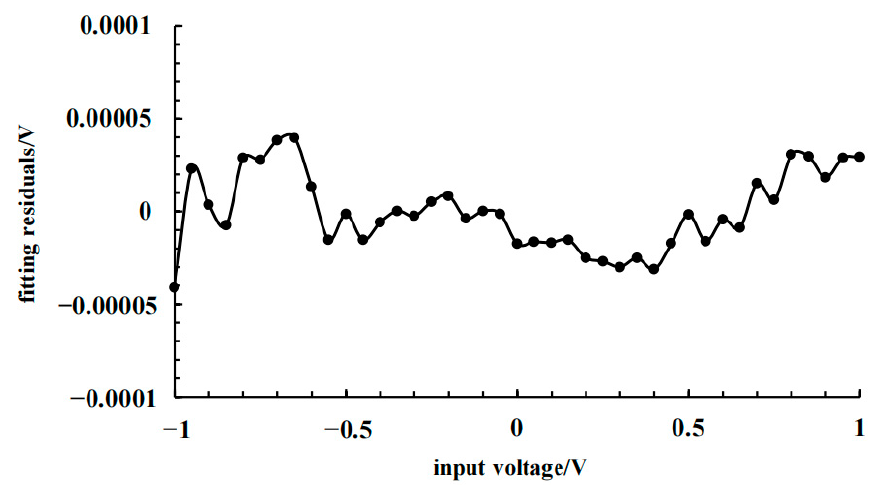
Figure 8. Fitting residual diagram.